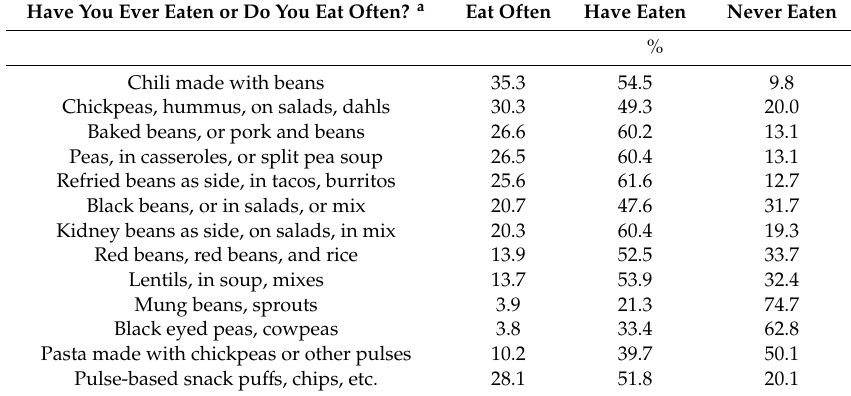
Table 1. Consumption frequencies of pulses and pulse food items of students enrolled at a Midwestern US university by (%; n = 1433).